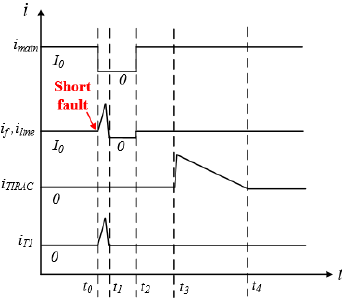
Figure 4. Typical current curves of BSCCB.